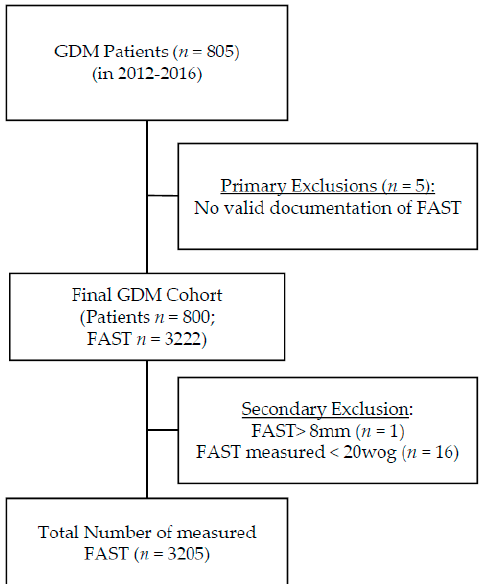
Figure 2. Cohort composition—the primary cohort consists out of 805 singleton GDM (gestational diabetes) pregnancies, supervised in our outpatient department for diabetes and pregnancy from 1st January 2012 to the 31st December of 2016. We excluded five mothers due to missing FAST (fetal abdominal subcutaneous tissue) values, one value was excluded due to implausible FAST > 8 mm and 16 because measurements were derived before 20 weeks of gestation. Finally, 800 pregnancies with 3205 FAST measurements were included.